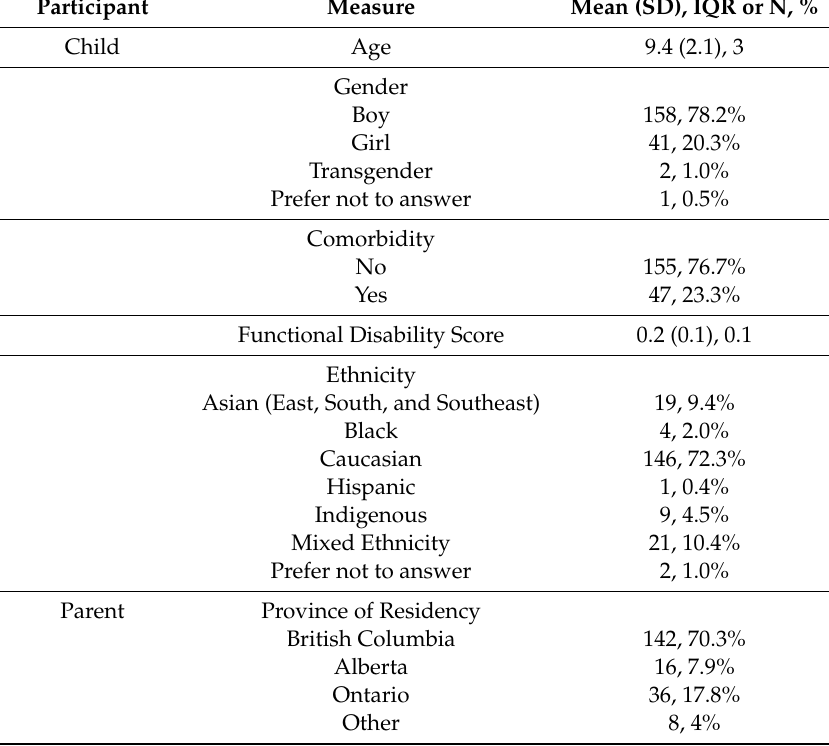
Table 1. Descriptive characteristics of child- and parent-level